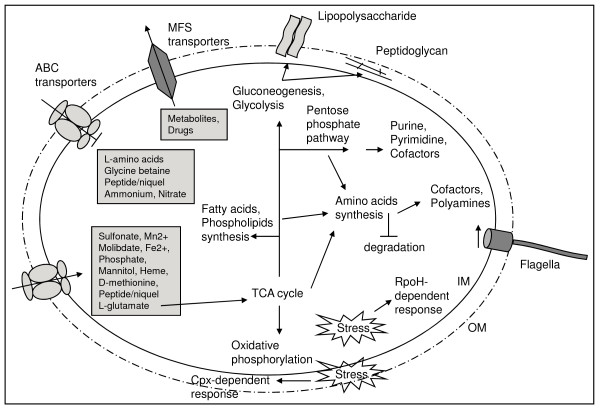
Altered pathways and phenotypes on the dependence of tolC mutation in S. meliloti as depicted from the expression data. Arrows represent processes/pathways whose genes displayed increased expression and blocked arrows decreased expression in absence of a functional TolC protein. IM, inner membrane; OM, outer membrane.